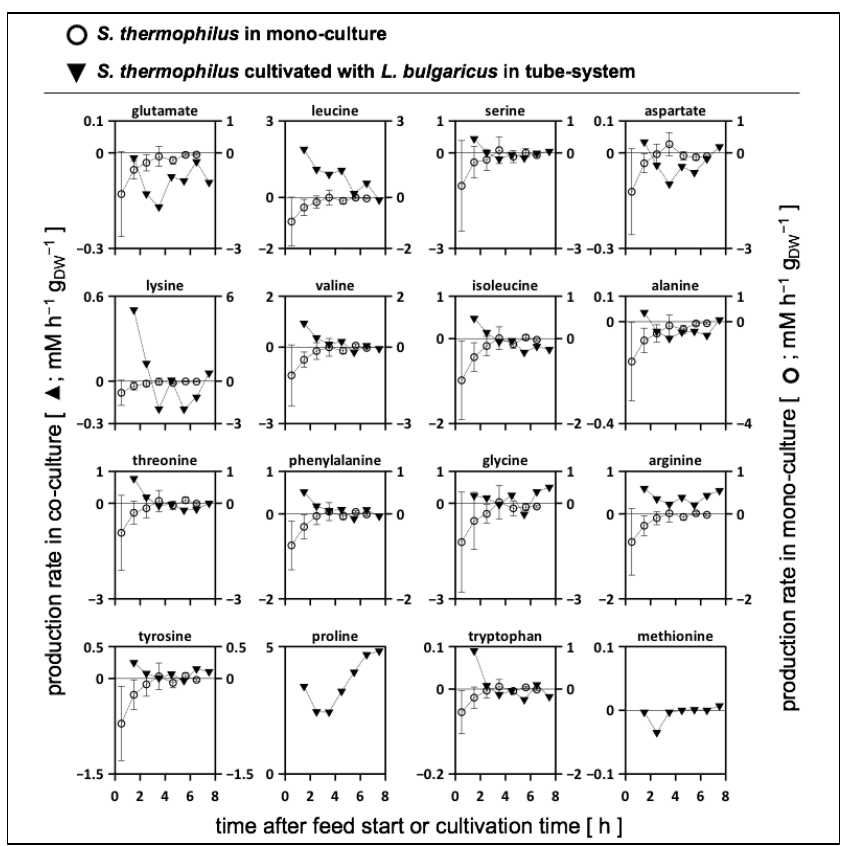
Figure 5. Biomass-specific activity of Streptococcus thermophilus . Amino acid production or consumption rates of S. thermophilus bridging amino acid productivity in mono-culture and co-culture. ( Filled ) S. thermophilus grown in co-culture with Lactobacillus delbrueckii subs. bulgaricus . Strains were cultivated in a tube bioreactor system containing synthetic medium (SM) with casein and glucose in the L. bulgaricus compartment and SM with glucose in the S. thermophilus compartment. ( Non-filled ) S. thermophilus grown in a crimp-top serum bottle containing SM with amino acids and lactose (modified from [62]). Amino acids were sorted in rows according to mol-fraction in casein, except tyrosine, proline, tryptophan, and methionine.